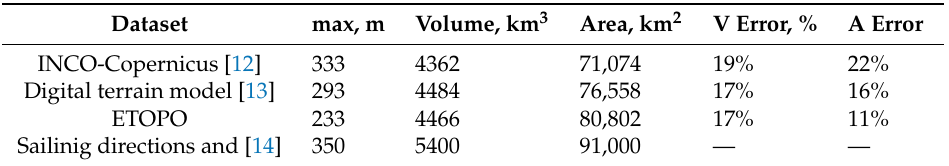
Table 1. Sea depth, area, and volume according to different bathymetry data sets. Relative error is with respect to the sailing directions